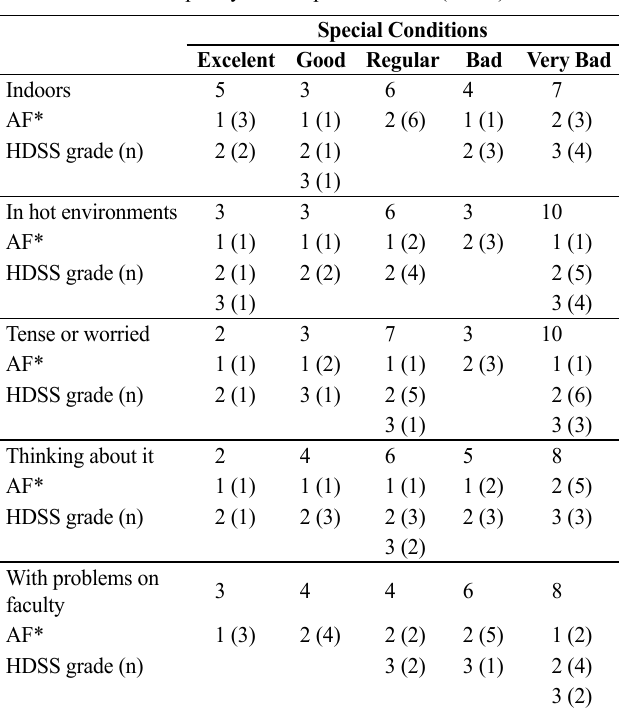
Table 7: Domain distribution Special conditions of the 25 Physical Education students with primary hyperhidrosis of a private universi- ty of Aracaju-SE, from August to November 2017, according to the classification of the quality of life questionnaire. (25.24)